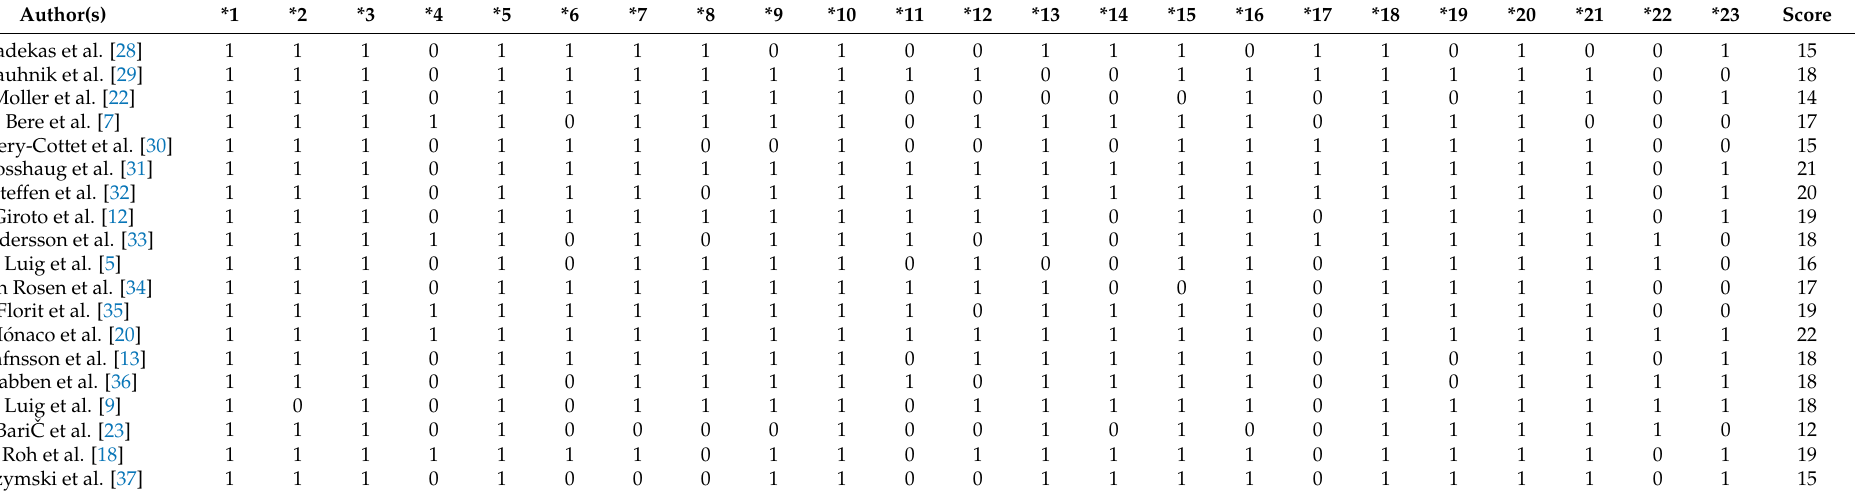
Table 4. Study quality assessment according to the Strengthening the Reporting of Observational Studies on Injury and Illness in